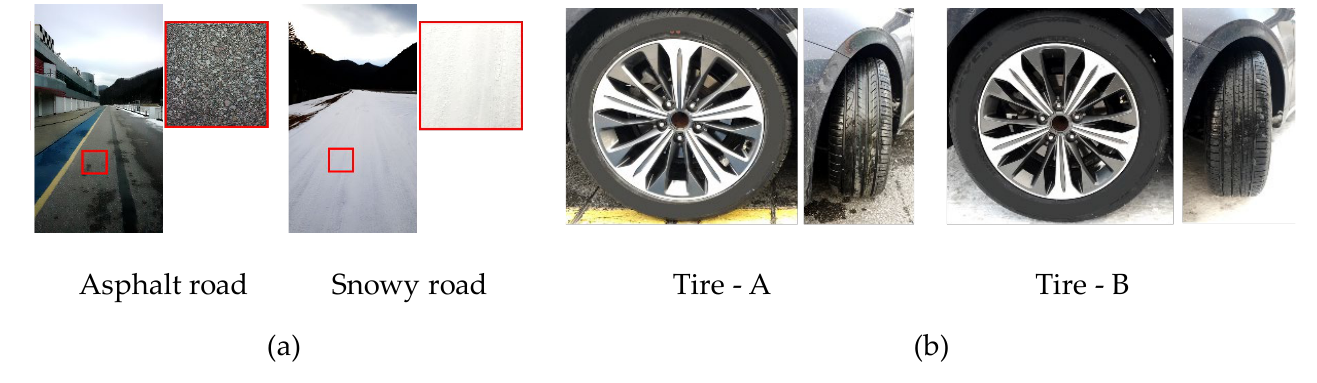
Figure 6. ( a ) Pictures of test roads; ( b ) pictures of test tires.